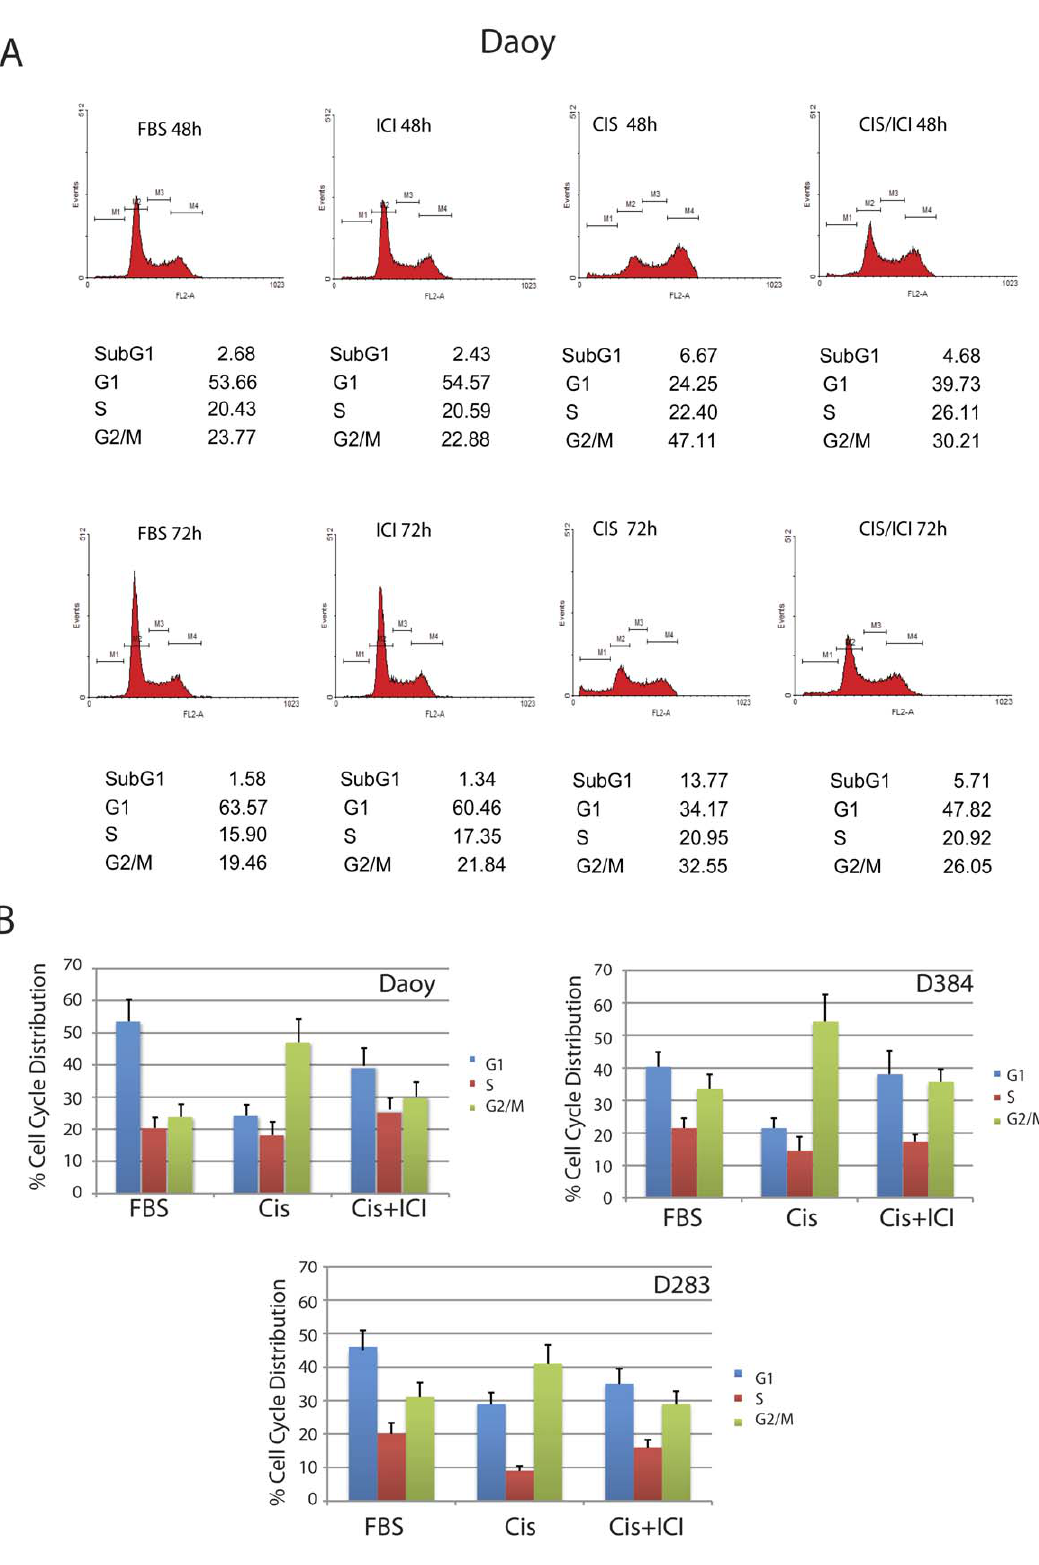
Figure 3. Effects of ICI182,780 on cell cycle distribution in cisplatin treated Daoy and D384Med cells. Exponentially growing cultures of Daoy, D384Med and D283 Med cells were treated with cisplatin (0.25 m g/ml) or with cisplatin + ICI182,780 (10 m M) for 24 (not included), 48 and 72 hours. Aliquots of 1 6 10 6 cells/ml were fixed in 70% ethanol; the cells were centrifuged, labeled with propidium iodide/RNaseA solution and evaluated by Calibur flowcytometer and WinMDI 2.9 software. Panel A: Diagrams of cell cycle distribution (Daoy) from one representative experiment, which was repeated three times with a similar outcome. Panel B: Average data of cell cycle distribution (G1, S, G2/M) for Daoy, D384Med and D283Med cells with standard deviation (n=3). Note the presence of a reproducible shift from G2/M to G1 cell cycle arrest between cisplatin-treated and cisplatin + ICI182,780-treated cells at 48 hrs time point. doi:10.1371/journal.pone.0033867.g003 PLoS ONE |